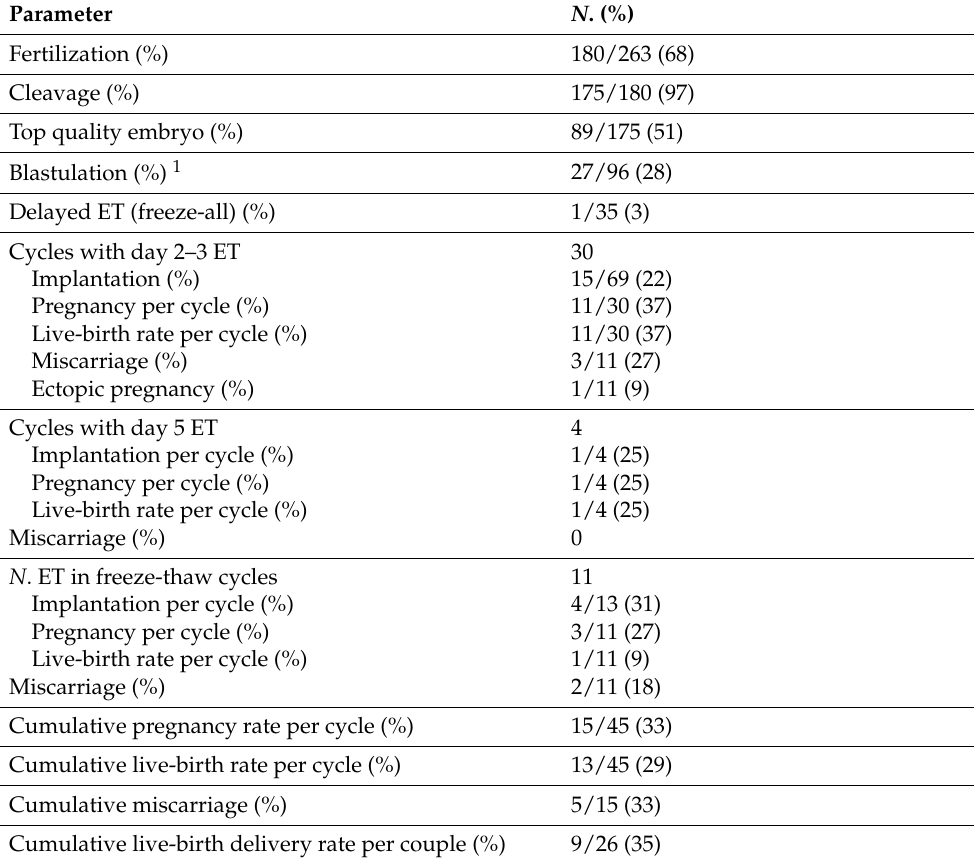
Table 1. Embryological and clinical outcomes of ART (34 ICSI + 11 frozen embryo embryo transfer